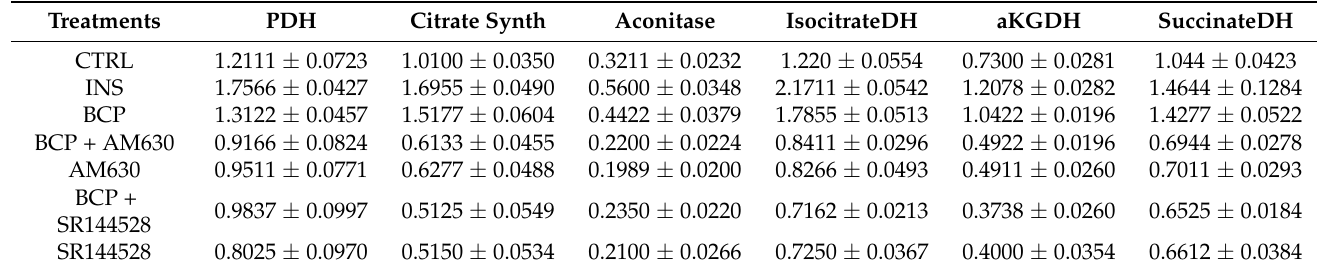
Table 2. BCP effects on mitochondrial pathway.